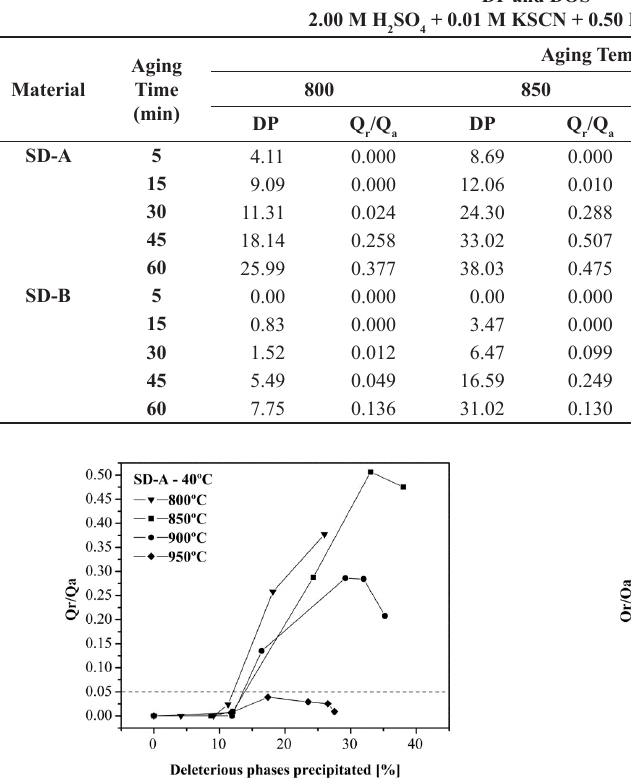
Table 5. Deleterious phases precipitated (DP) percentage and Q + 0.50 M NaCl solution test at 40